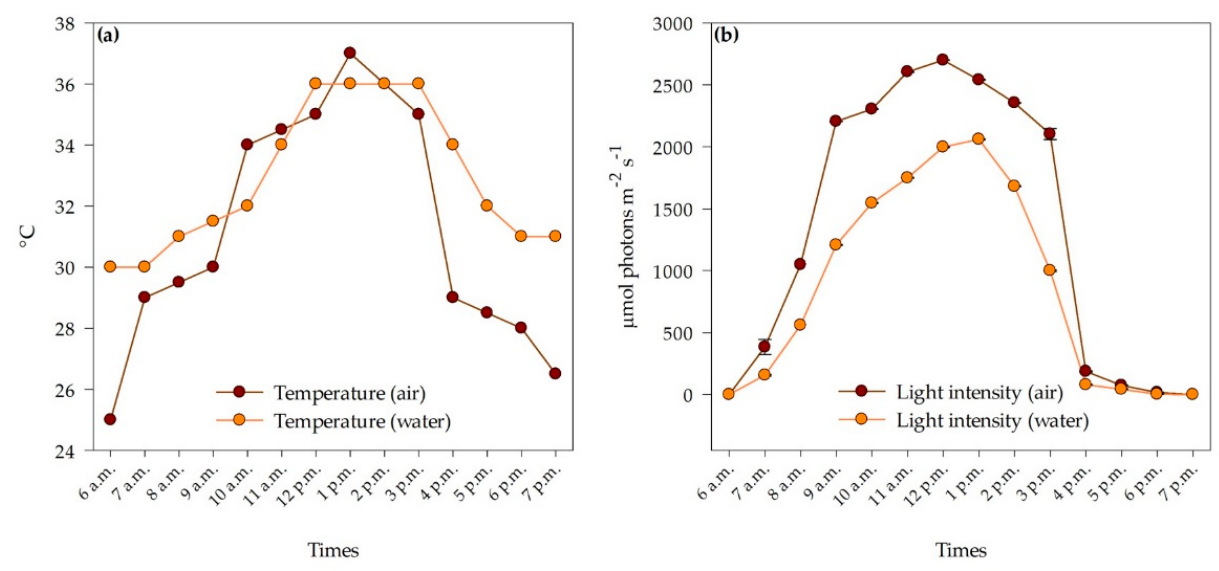
Figure 1. Air and water temperatures ( a ) and light intensity of air and water ( b ) at Thale Noi, Songkhla Lake from 6 a.m. to 7 p.m. ( n = 3). Data represent mean ± SE.